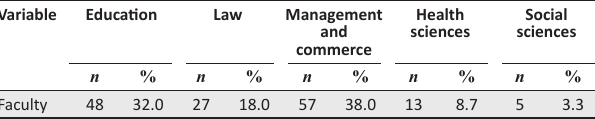
TABLE 3: Number of students per faculty. Variable